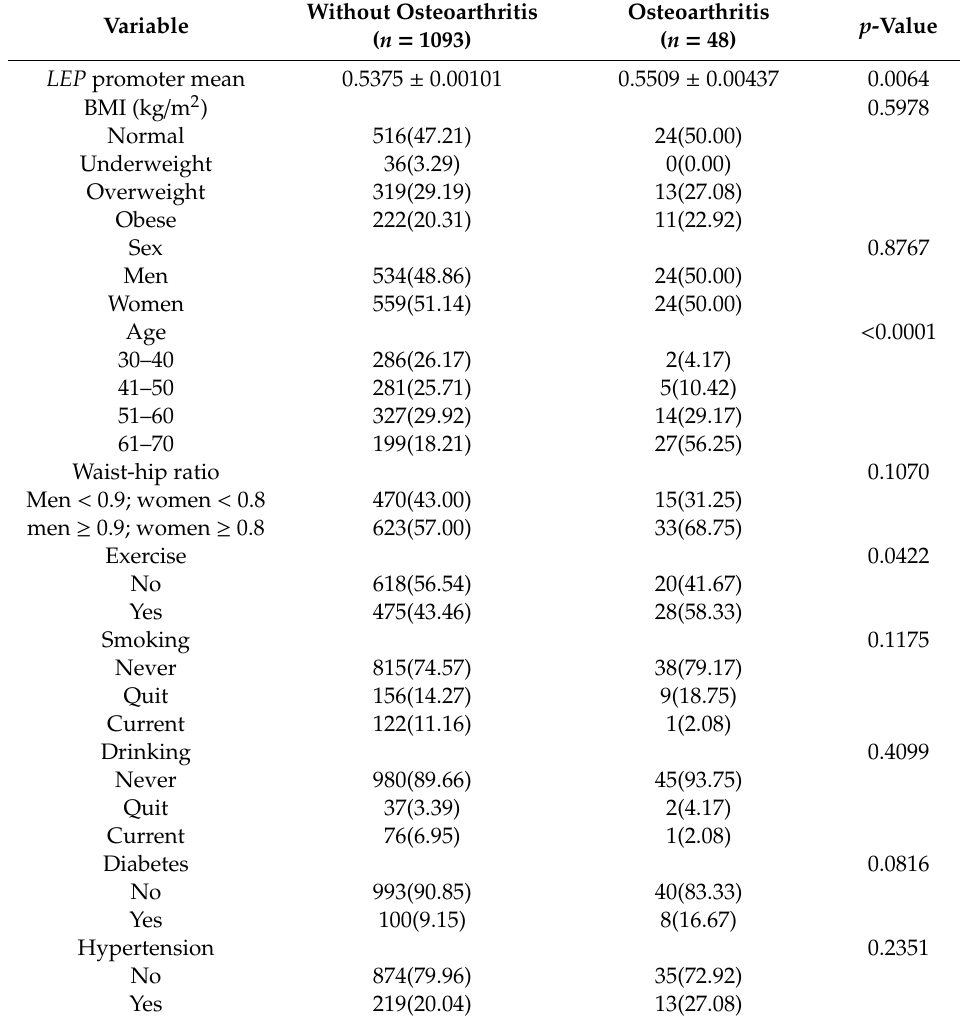
Table 1. Basic characteristics of participants stratified by osteoarthritis